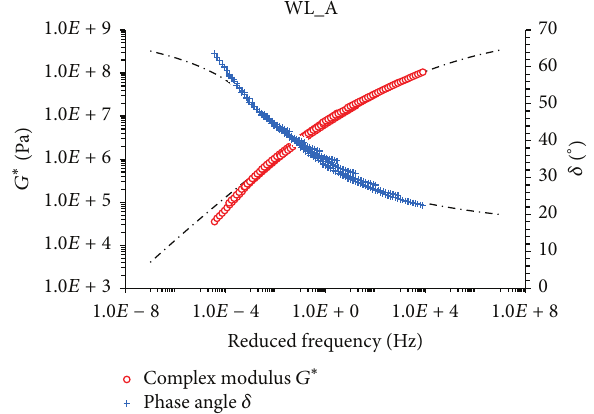
Figure 3: Master curves at 34 ∘ C and measured shifted data for 𝐺 ∗ and 𝛿 (sample WL A).